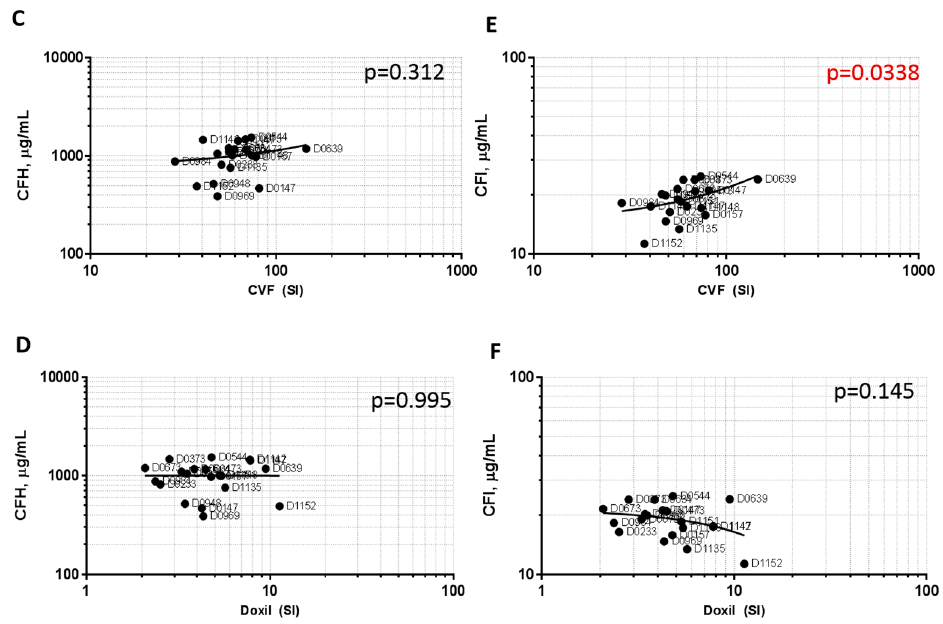
Figure 6. Plasma levels of complement inhibitory factors and their role in the complement activation. Plasma collected from 20 healthy donor volunteers and used in the complement activation and antibody titer study was also analyzed for the levels of CFH ( A ) and CFI ( B ). Regression analysis was performed to understand the correlation between the concentration of CFH and the complement activation by CVF ( C ) or Doxil ( D ). Regression analysis was also performed to understand the correlation between the concentration of CFI and complement activation by CVF ( E ) or Doxil ( F ). The p -value indicates a significant positive correlation between CFI concentration and the complement activation by CVF. No correlation was observed between CFH concentrations and complement activation by both Doxil and CVF, nor was it observed between CFI concentrations and the complement activation by Doxil.